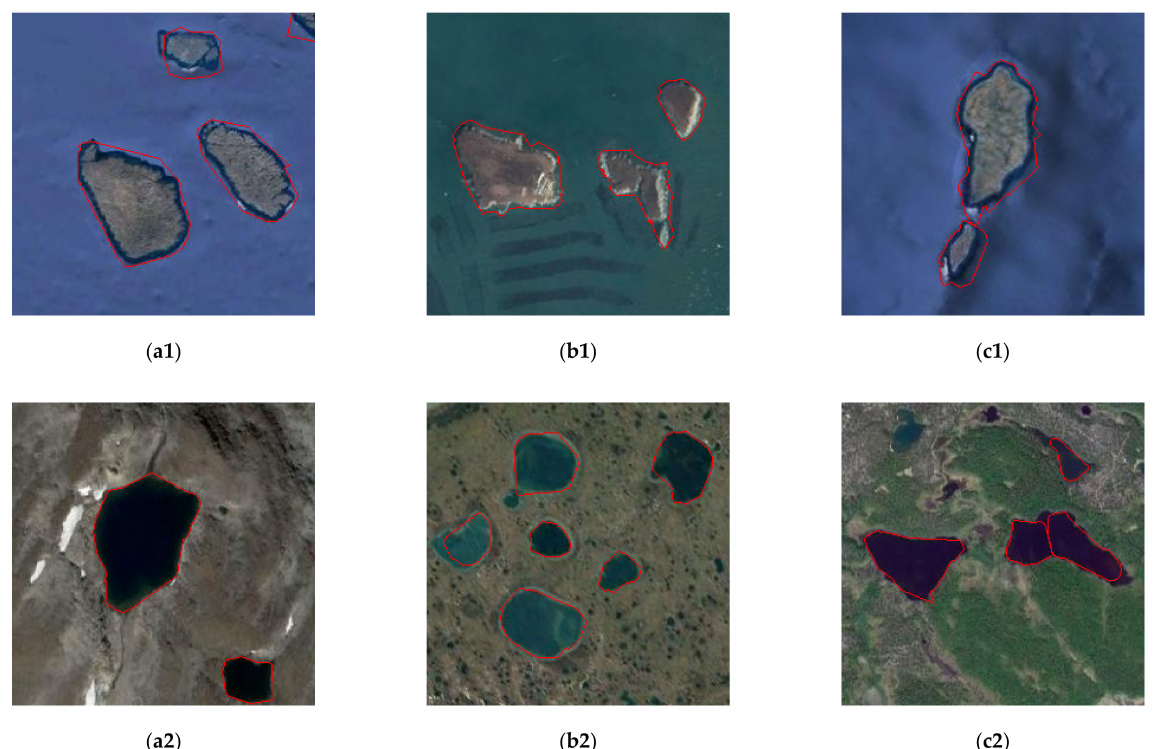
Figure 15. Visual evaluation of multispectral remote sensing images: ( a1 ) Island image 1; ( b1 ) Island image 2; ( c1 ) Island image 3; ( a2 ) Lake image 1; ( b2 ) Lake image 2; ( c2 ) Lake image